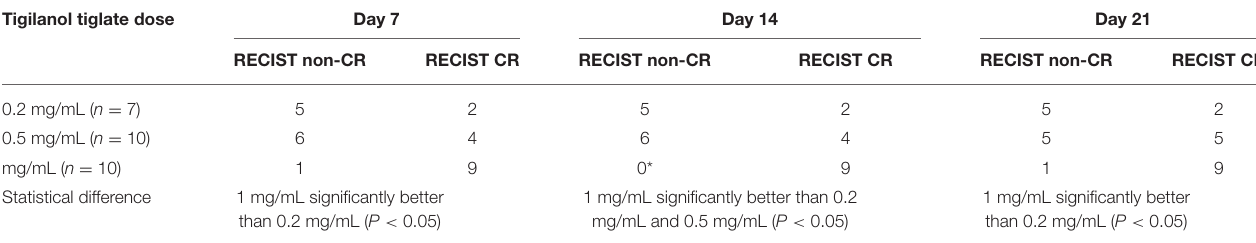
TABLE 5 | RECIST response rate at days 7, 14, and 21. Tigilanol tiglate dose Day 7 Day 14 Day 21 RECIST non-CR RECIST CR RECIST non-CR RECIST CR RECIST non-CR RECIST CR